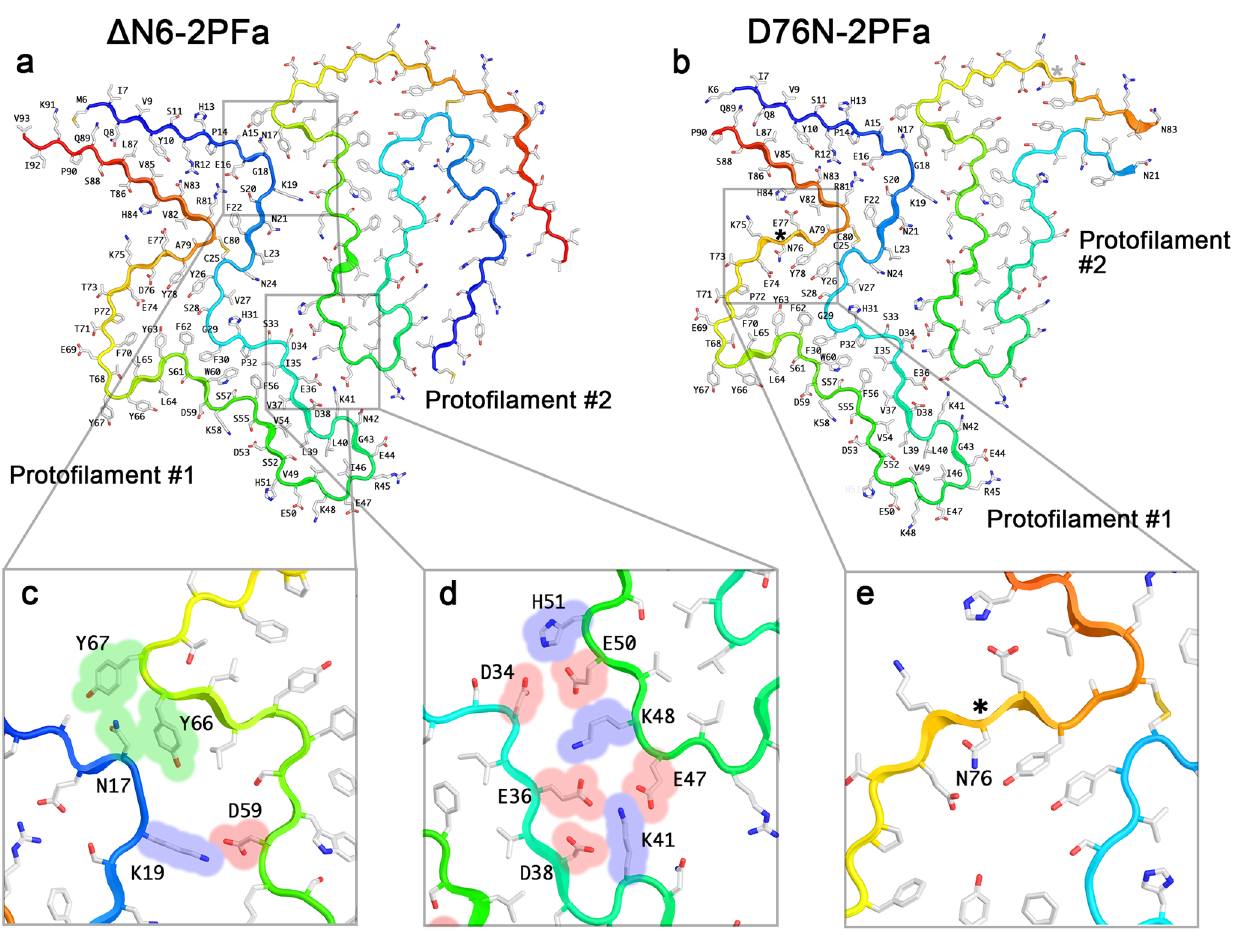
Fig.7|Side-by-sidepolymorphsarebuiltusingpolar/chargedinteractionsand require an ordered N- and C-terminus. The atomic models for a , β 2 m- Δ N6-2PFa and b , β 2 m-D76N-2PFa are shown in cartoon representation, with the backbone cartoon coloured from N- to C- terminus (blue to red). For each, sidechains are shown in stick representation and coloured as CPK. Residues in proto fi lament #1 are explicitly labelled. Interactions that hold the two fi laments together are similar